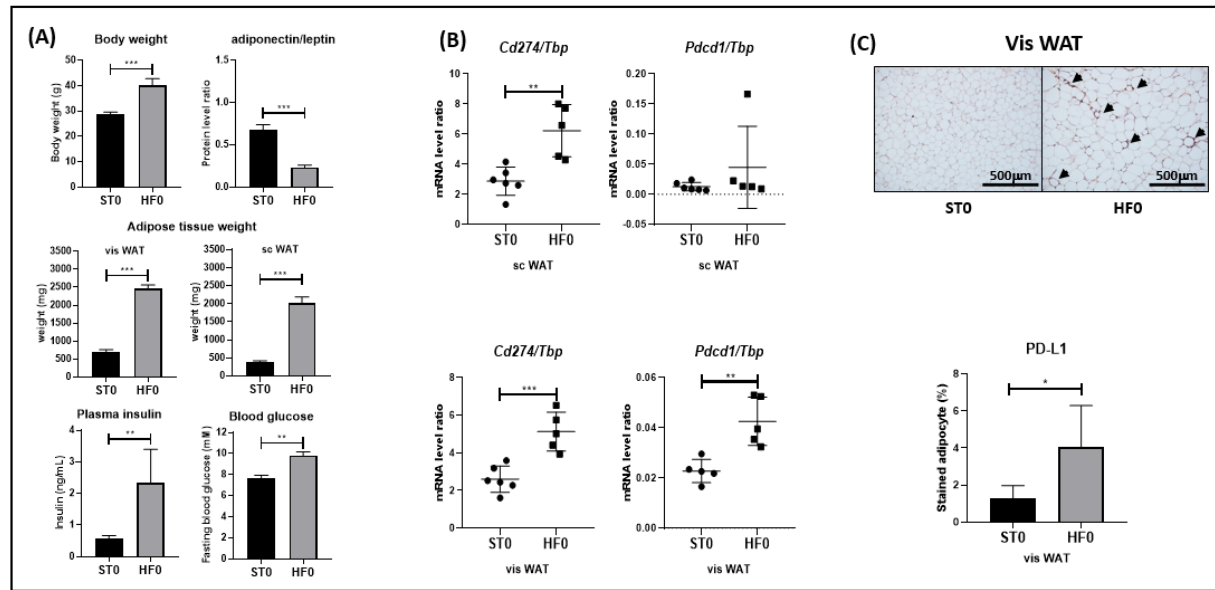
Figure 1. PD-L1 and/or PD-1 are overexpressed in the WAT of obese mice. C57BL/6 mice were fed with a normal or hypercaloric diet for 16 weeks (STO versus HFO). ( A ) Body and adipose tissue weight were measured, together with plasma insulin and blood glucose, after sacrifice. ( A , B ) serum adiponectin and leptin were measured by ELISA. Cd274(Pdl1) and Pdcd1(Pd1) mRNA were extracted from subcutaneous (sc) or visceral AT and their levels measured by RT-PCR. ( C ) Immunohistochemistry staining of PD-L1 in vis WAT. Results are expressed as a ratio relative to the Tbp housekeeping gene. ( A , C ) Black or grey histograms correspond to STO, or HFO mice, respectively. ( B ) Black circles, or black squares correspond to STO, or HFO mice, respectively. ( C ) Black triangles correspond to positively stained PD-L1 molecules..Two- tailed unpaired t -tests were used to prove the statistical significance of the results when p was <0.05. ***, **, * represents a p -value of <0.001 <0.01,<0.05 respectively. Data are the mean ± SD of n = 6, or 5 for STO or HFO, respectively.